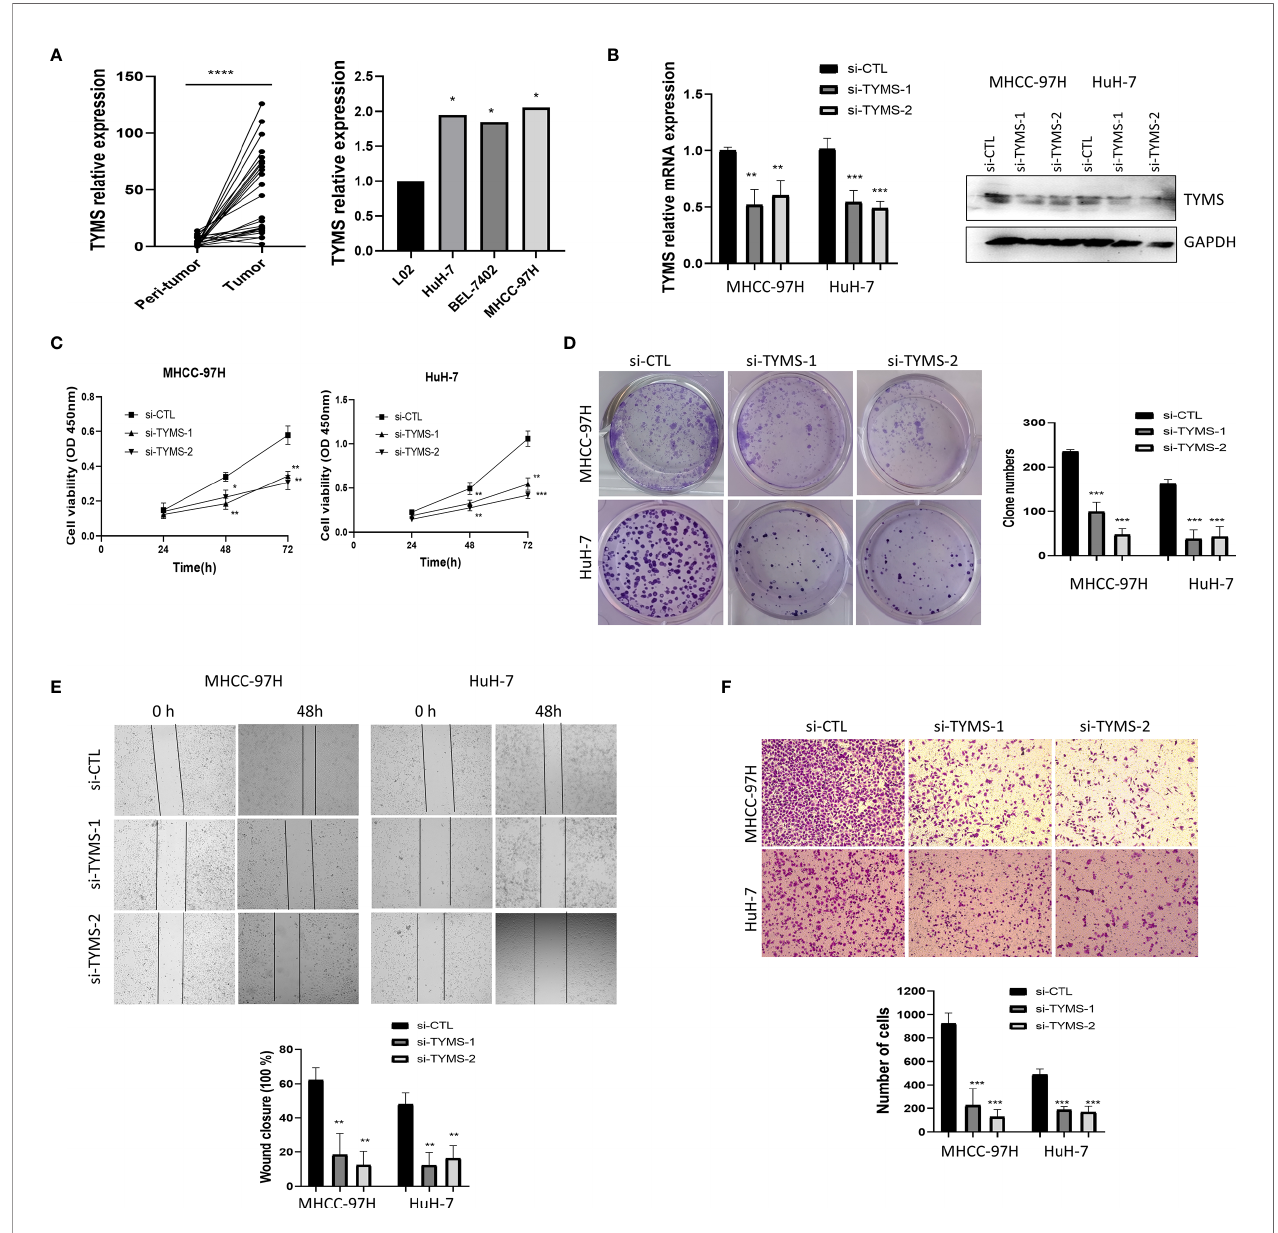
FIGURE 6 | TYMS affect cell growth and invasion in MHCC-97H and HuH-7 cells. (A) The mRNA expression of TYMS in 24 pairs of HCC tissues and HCC cell lines. (B) The expression of TYMS in MHCC-97H and HuH-7 cells. The expression of TYMS was detected by qPCR and western blot. The 2 − DD Ct method was used to quantify the mRNA fold changes, GAPDH was used as the internal control. (C) CCK8 assay was used to explore the effect of TYMS expression on cell viability. (D) Representative images and quanti fi cation of colony formation assay. The number of colonies with > 50 cells was scored after 14 days of incubation. (E) wound-healing analysis and (F) Transwell invasion assays represented the migration and invasion capacity of HCC cells. *P < 0.05, **P < 0.01, ***P < 0.001 and ****p <